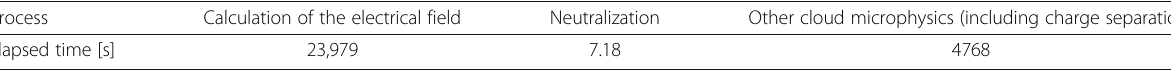
Table 1 Summary of elapsed time. Elapsed time of each process related to the lightning model during calculation of the last 12 h in the control simulation